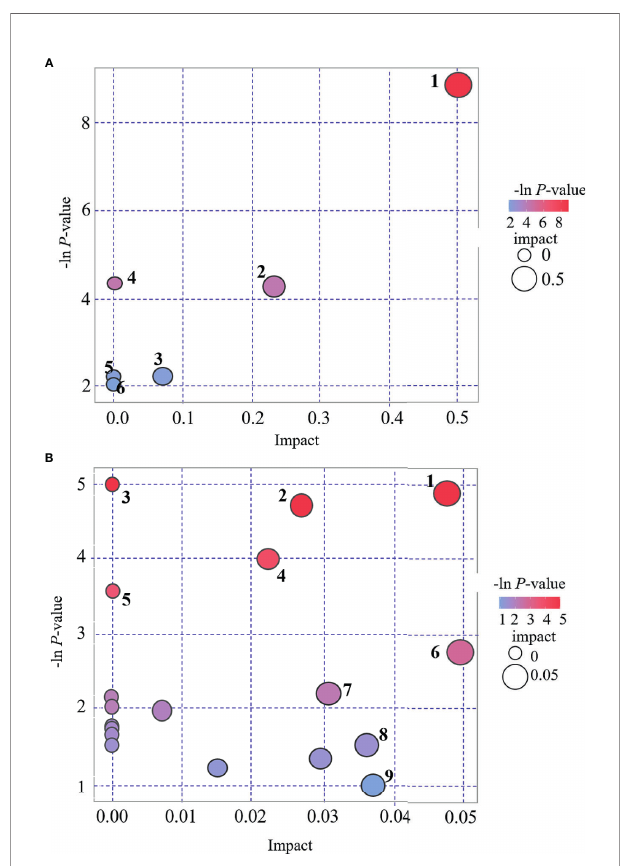
FIGURE 5 | Bubble plot for pathway analysis. (A) : POS mode. 1 = D -arginine and D -ornithine metabolism, 2 = arginine and proline metabolism, 3 = lysine degradation, 4 = Aminoacyl-tRNA biosynthesis, 5 = fatty acid metabolism, 6 = pyrimidine metabolism. (B) : NEG mode. 1 = tryptophan metabolism, 2 = valine, leucine and isoleucine biosynthesis, 3 = aminoacyl-tRNA biosynthesis, 4 = Valine, leucine and isoleucine degradation, 5 = fatty acid biosynthesis, 6 = tyrosine metabolism, 7 = caffeine metabolism, 8 = fructose and mannose metabolism, 9 = purine